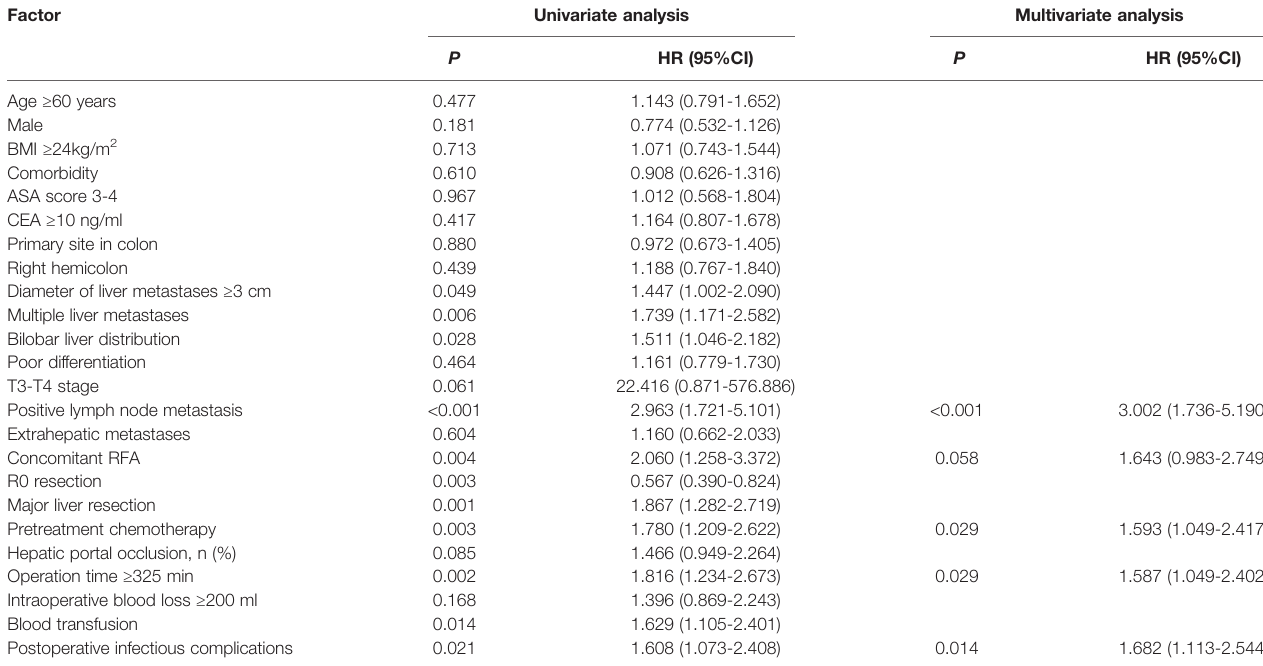
TABLE 7 | Prognostic factors for OS in CRLM patients after PSM. Factor Univariate